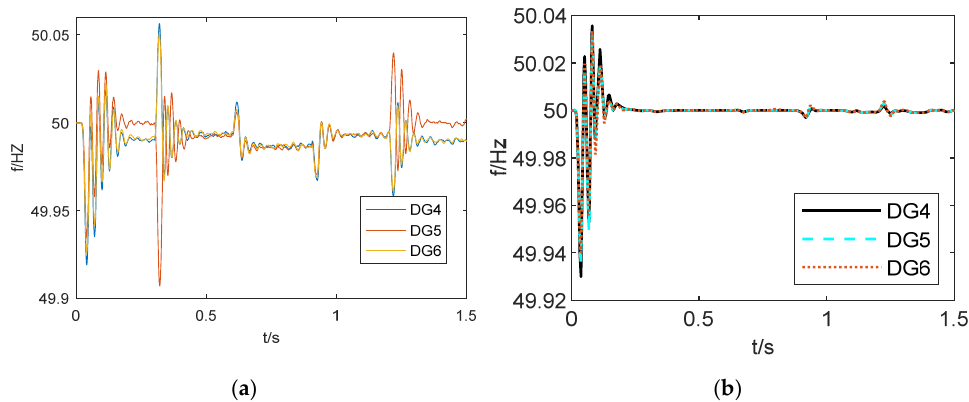
Figure 13. AC side power fluctuation process. ( a ) Schematic diagram of frequency fluctuation of each node at AC side under traditional droop control. ( b ) Schematic diagram of frequency fluctuation of each node at AC side based on OPPRA.